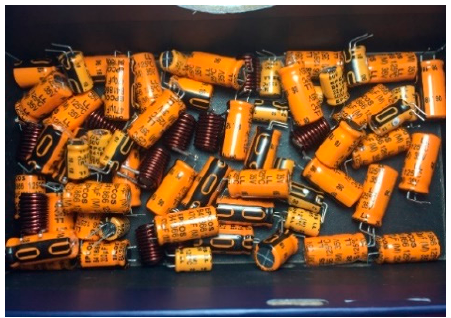
Figure 1. Electronic components.